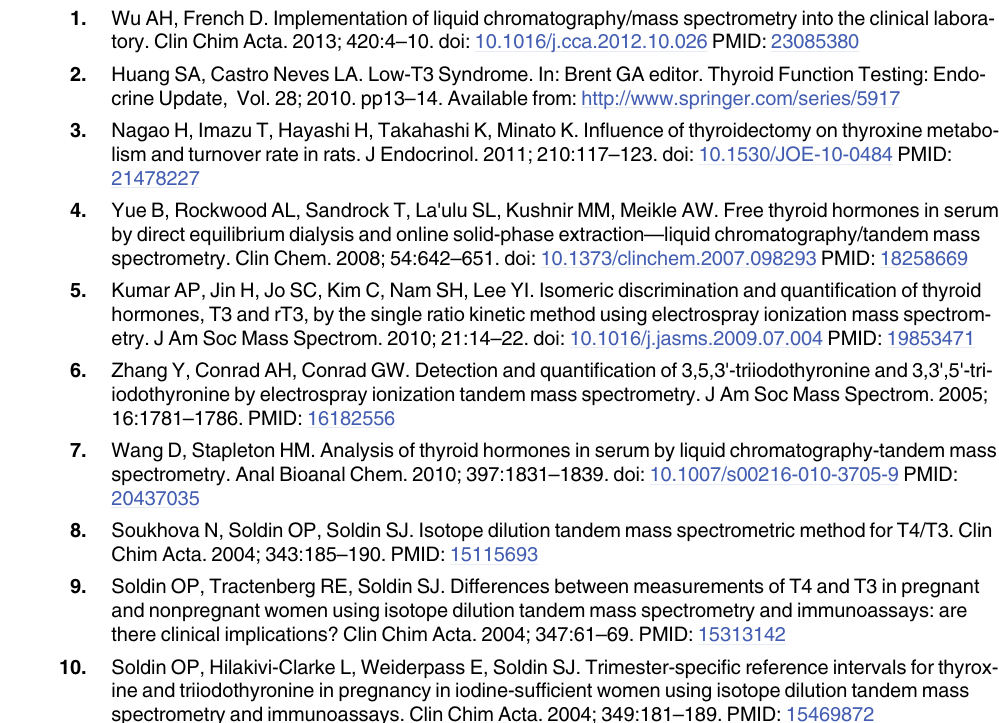
S1 Table. Matrix effects of T4, T3, and